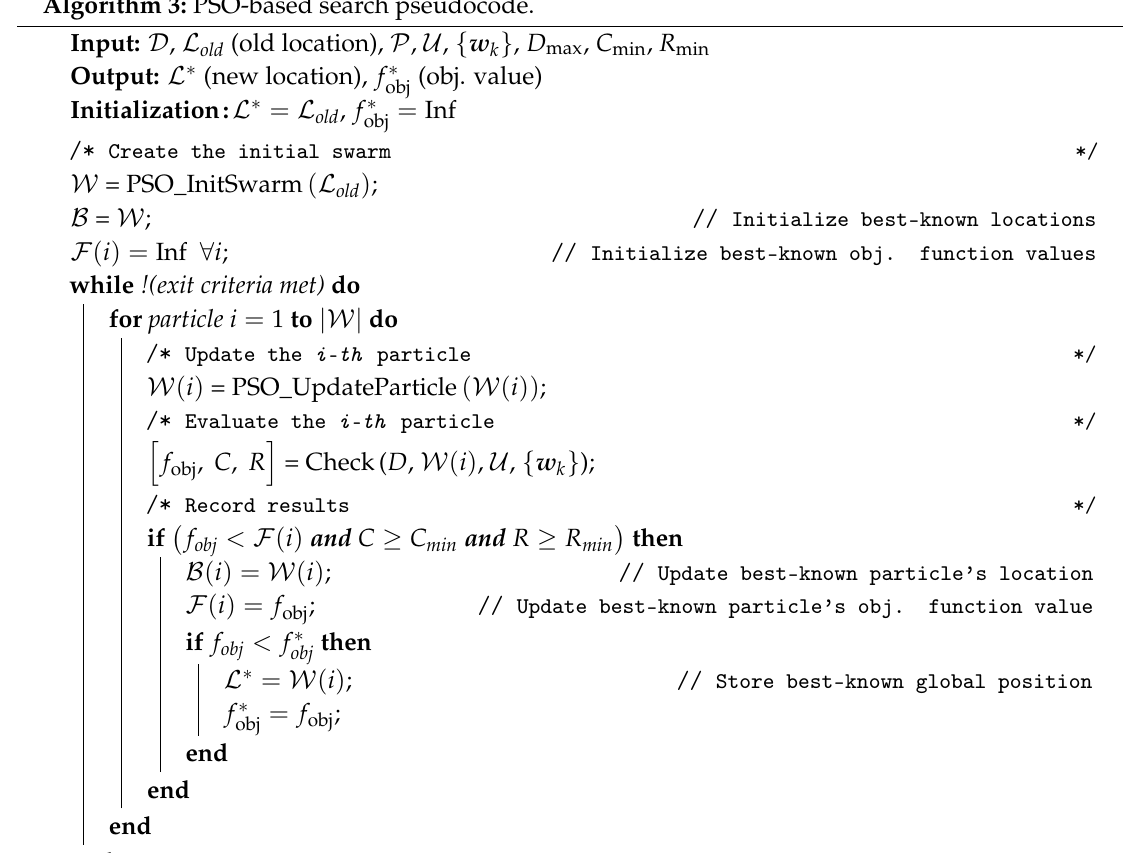
Algorithm 3: PSO-based search